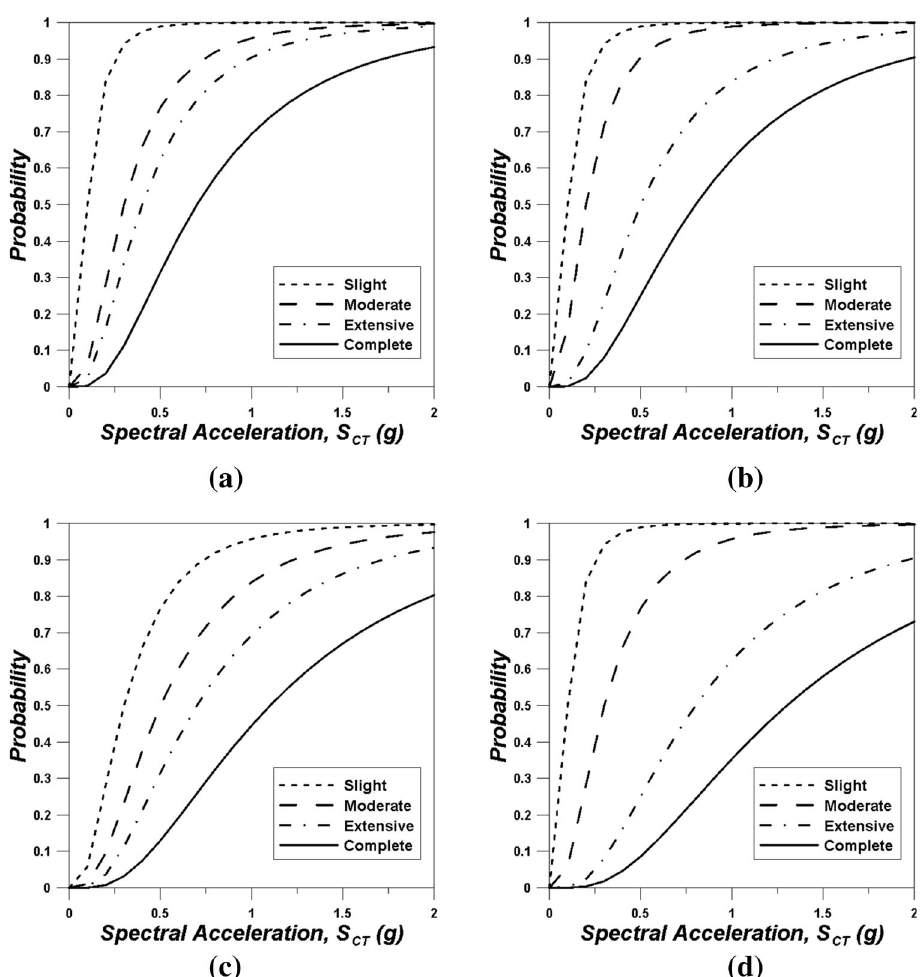
Fig. 24 Fragility curves of the model structures for reaching the four damage states. a Model SD, b Model CD, c Model CD_IC, and d Model